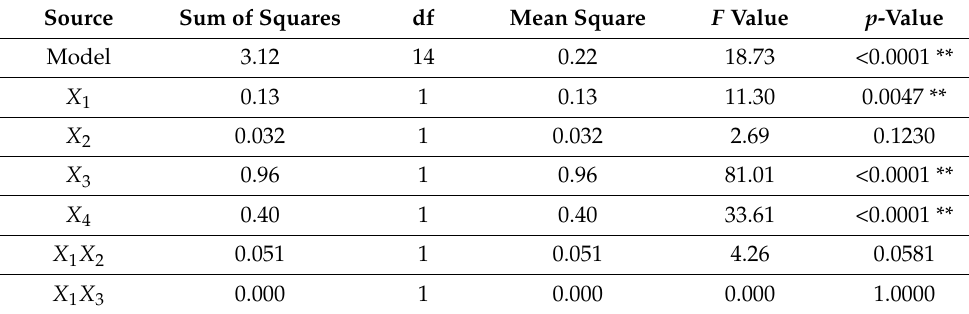
Table 2. ANOVA of the regression model for the prediction of syringopicroside